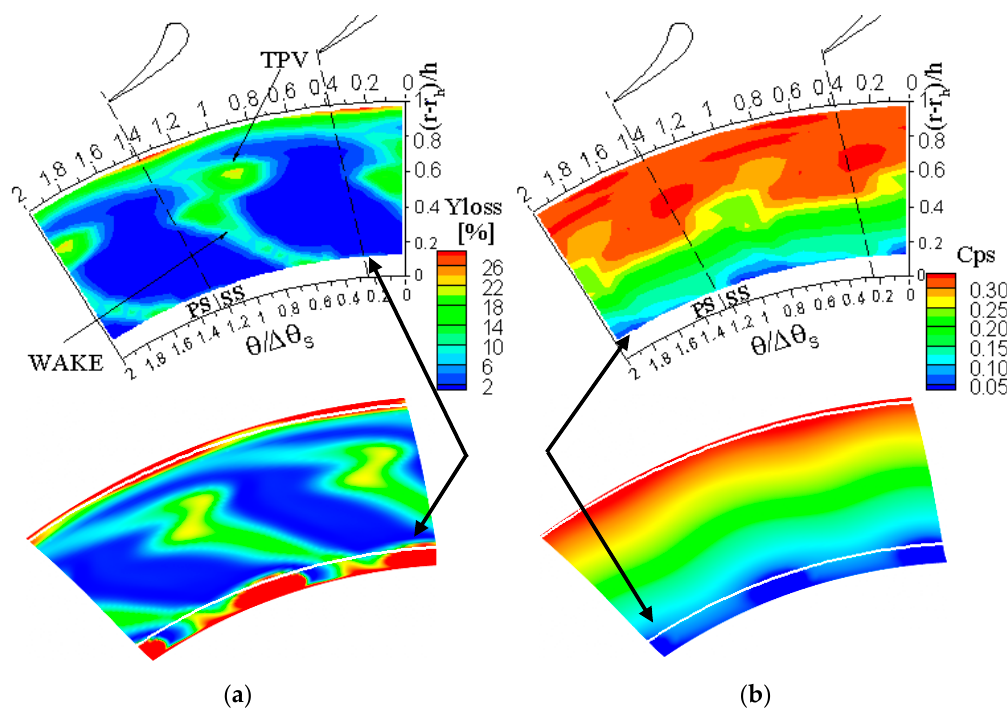
Figure 4. Time-averaged contours at the stator exit. Left-to-right: ( a ) Total pressure loss (Yloss); ( b ) Static pressure coefficient (Cps). Top: experiment. Bottom: CFD predictions.